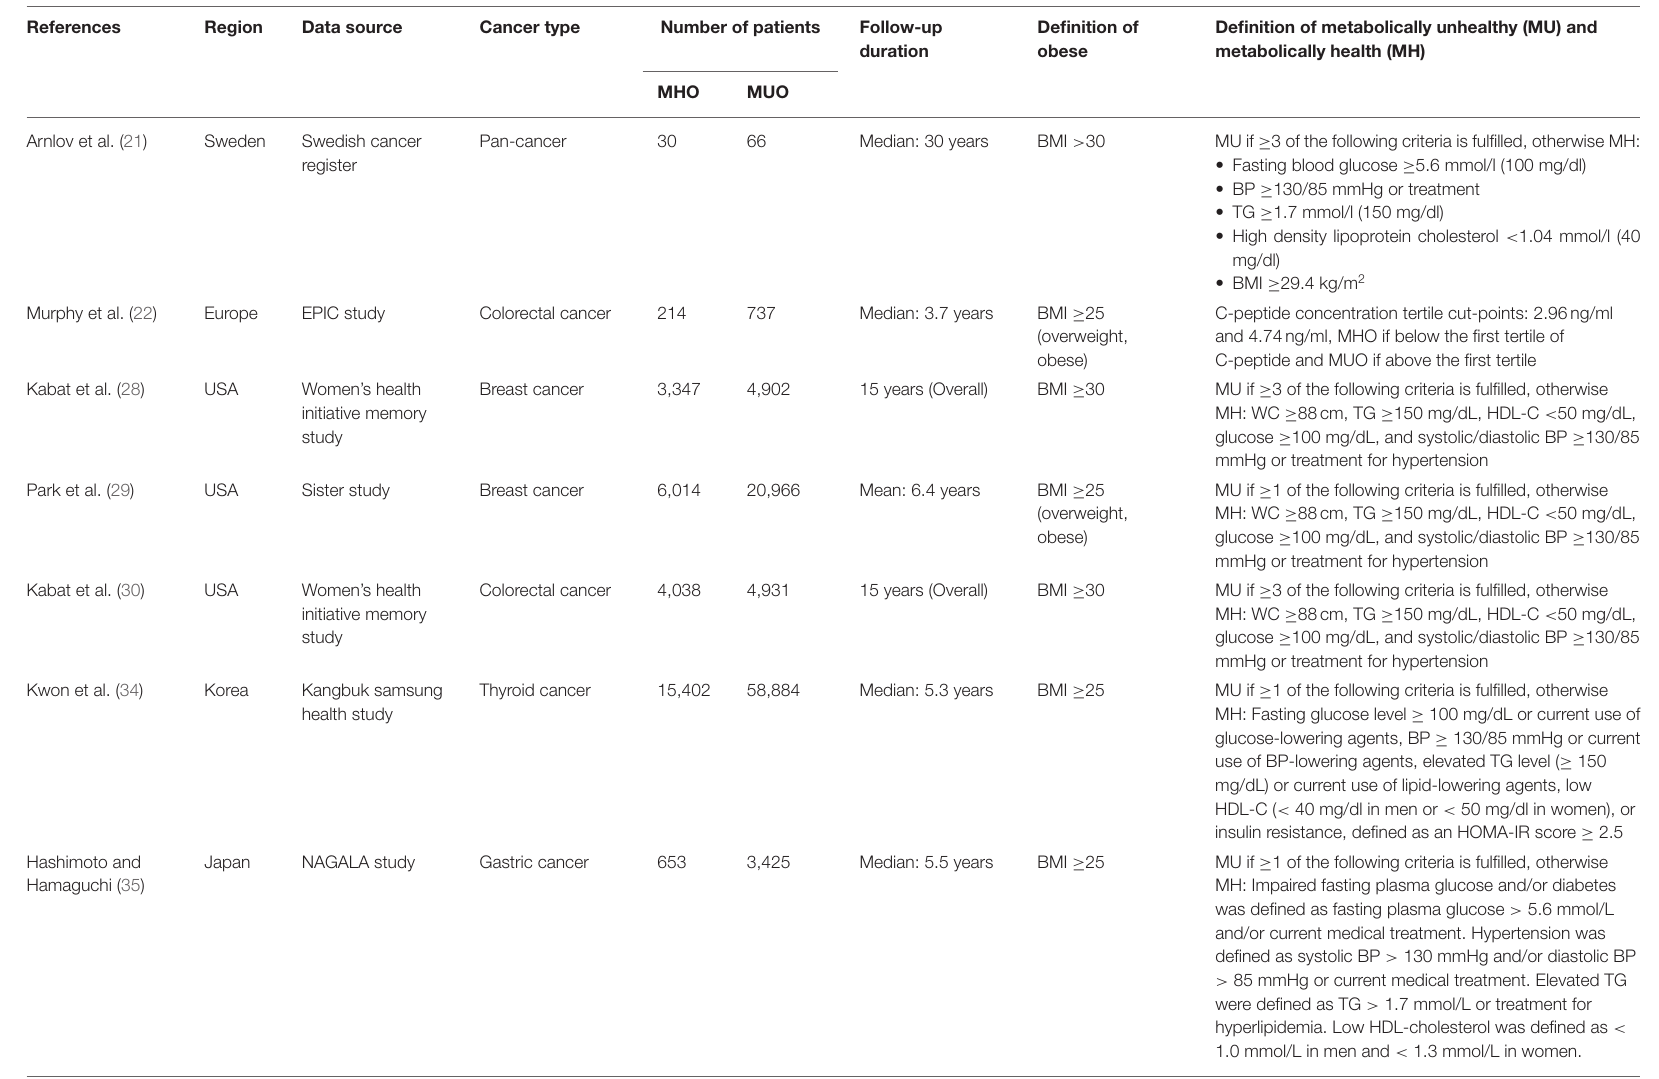
TABLE 1 | Characteristics of included studies.